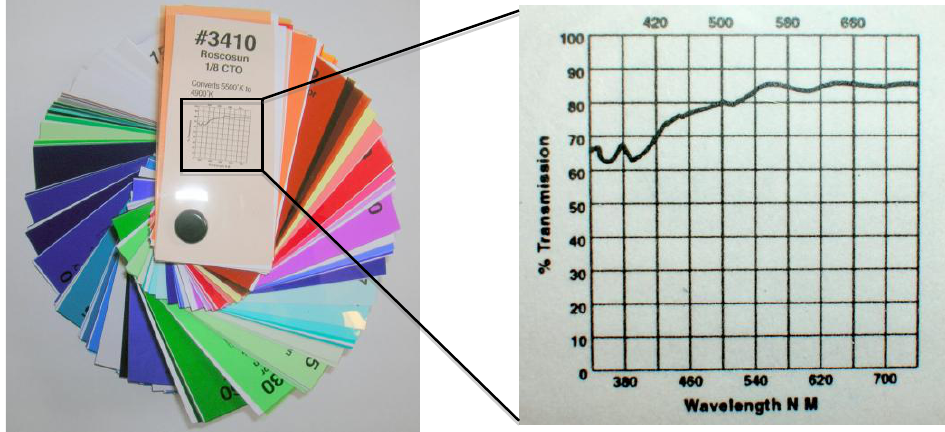
Figure 9 . Roscolux filter booklet from Edmund Optics (included in the total price of the fluorometer). A booklet contains over 200 filters, each with a graph showing percent transmission. These can be used over the light source or detector to measure fluorescence from numerous other substances in addition to chlorophyll a